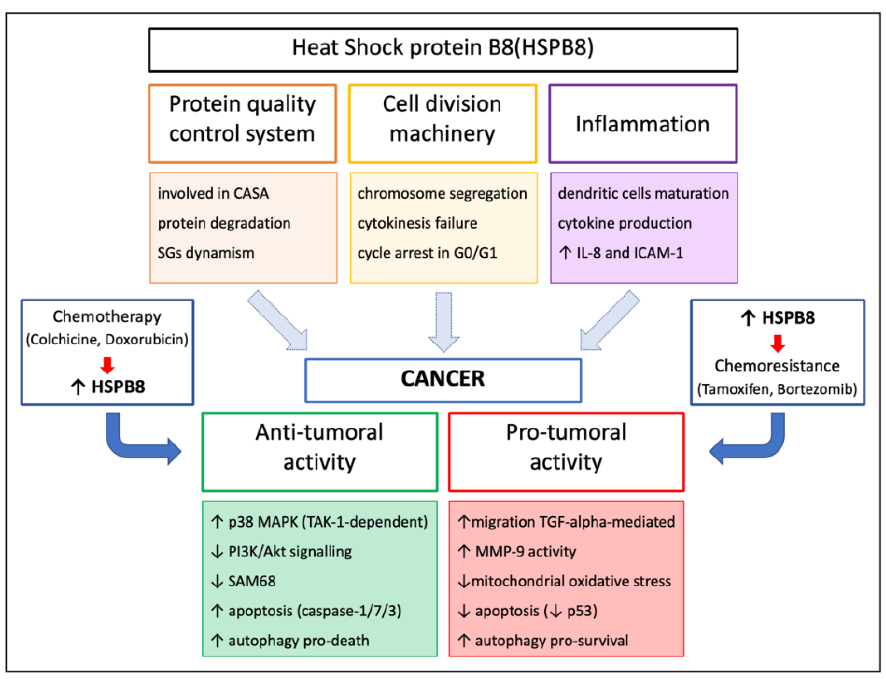
Figure 4. Schematic representation of HSPB8 roles in cancer development and progression.